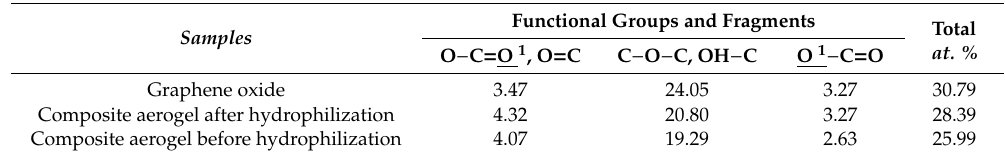
Figure 4. O 1s and C 1s XPS spectra of the samples: graphene oxide and aerogel before and after hydrophilization. Table 2. Oxygen content (in atomic percent) in the composition of functional groups and their fragments on the surface of various samples.